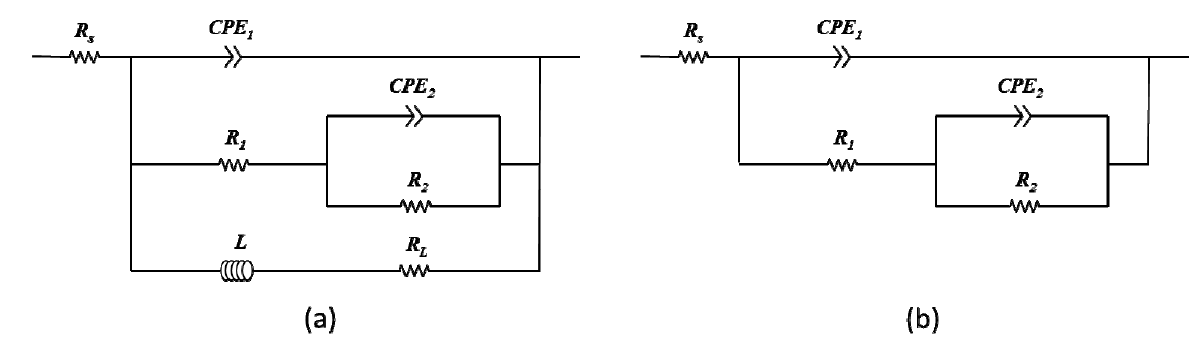
Figure 7. Schematic representation of corresponding equivalent electrical circuits of Electrochemical impedance spectroscopy (EIS) plots acquired in ( a ) Solutions #1 and #5; ( b ) Solutions #2, #3, #4, #6, #7 and